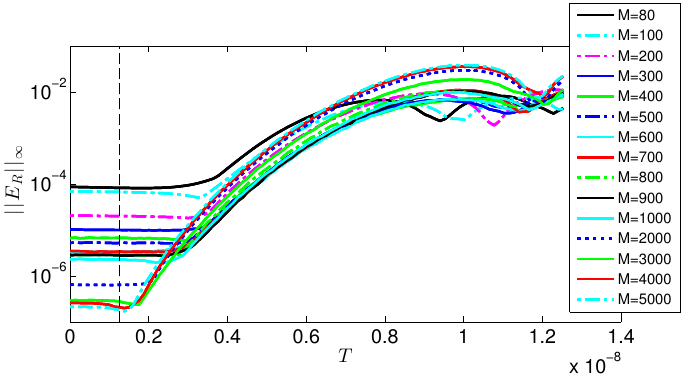
|| Figure 16. || E in the stripline example for various M . The vertical dashed line indicates R ∞ the closed form microwave theory time delay approximation T